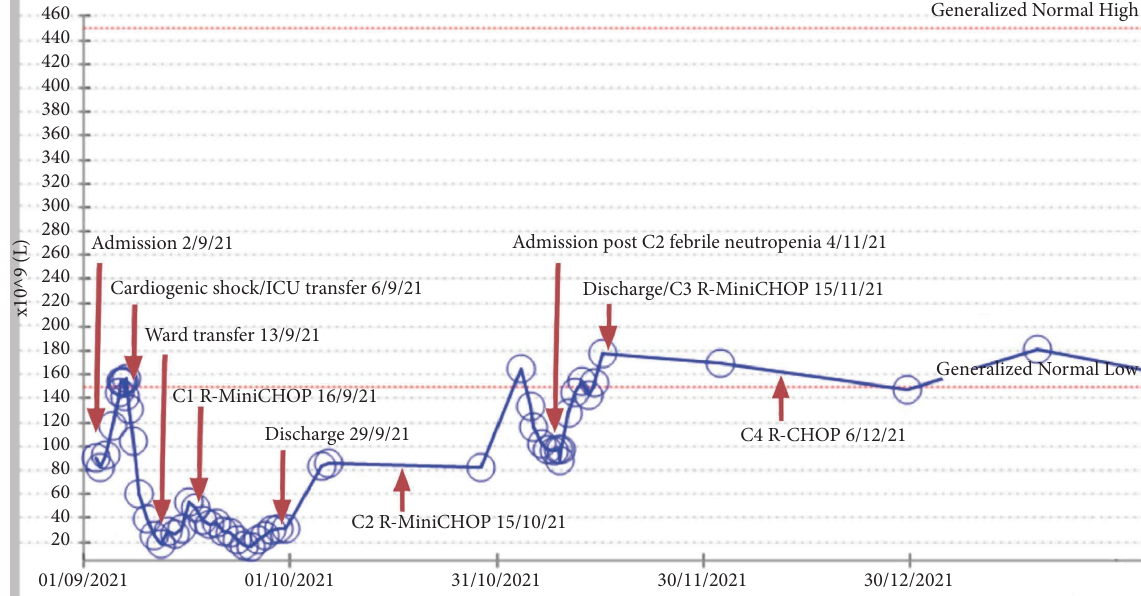
Figure 2: Trend of platelet count in units 10 9 /L throughout treatment.